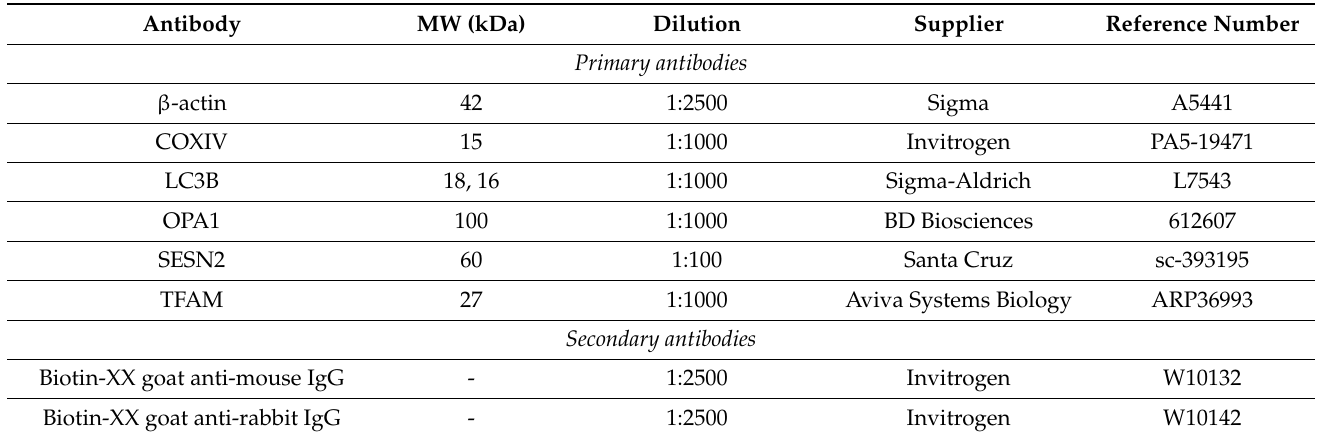
Table 2. Primary and secondary antibodies used in Western